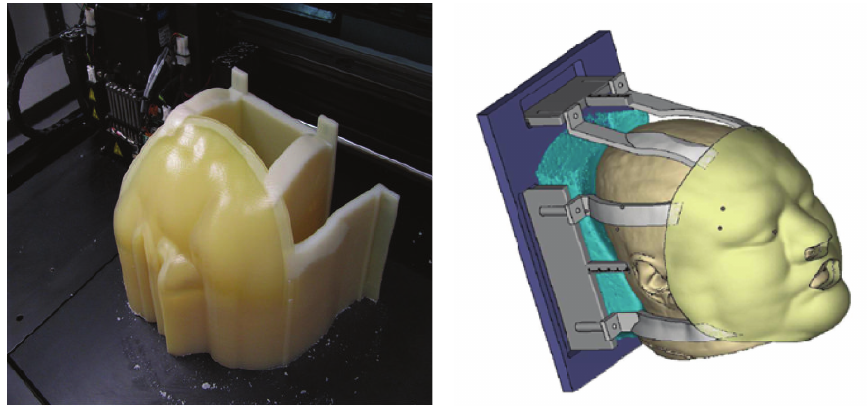
Figure 2: Fabrication of immobilization mold using customized